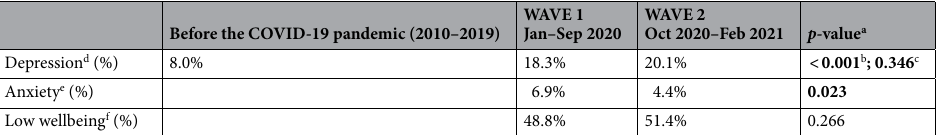
Table 2. Prevalence of positive screening for depression, anxiety and low wellbeing using the Edinburgh Postnatal Depression Scale (EPDS) and the WHO-5 index for the two periods during the pandemic (February- September 2020 and October 2020-February 2021) and comparisons with positive screening for depression during the period 2010–2019 from a previous study cohort. Statistically Significant values are given in bold. a Chi-square derived p -value representing comparison of average proportions. b Comparisons between each wave and the average 2010–2019. c Comparisons between each wave or each wave and the average 2010–2019. d Based on an EPDS total score ≥ 13. e Based on an EPDS-3A total score ≥ 7. f Based on a WHO-5 total score <